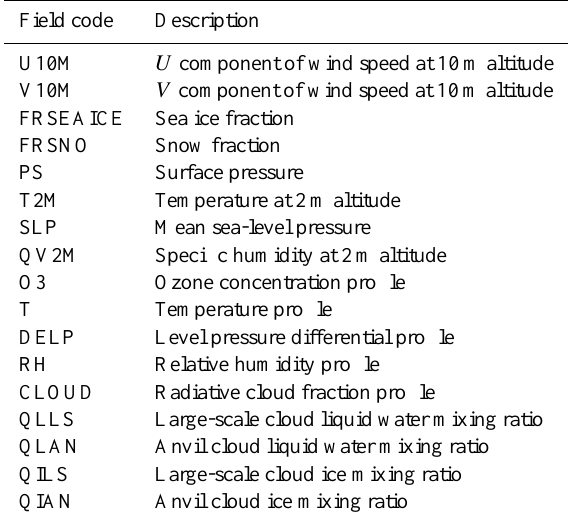
Table 1. GEOS v.5.7.2 fields and products used in